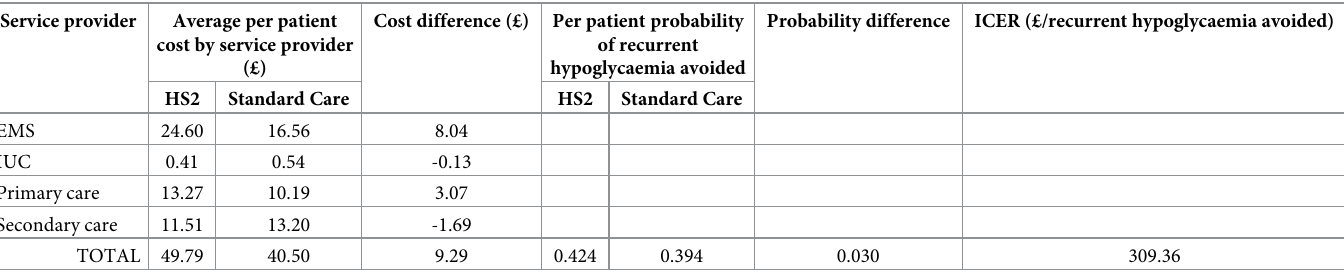
Table 4. Baseline modelling